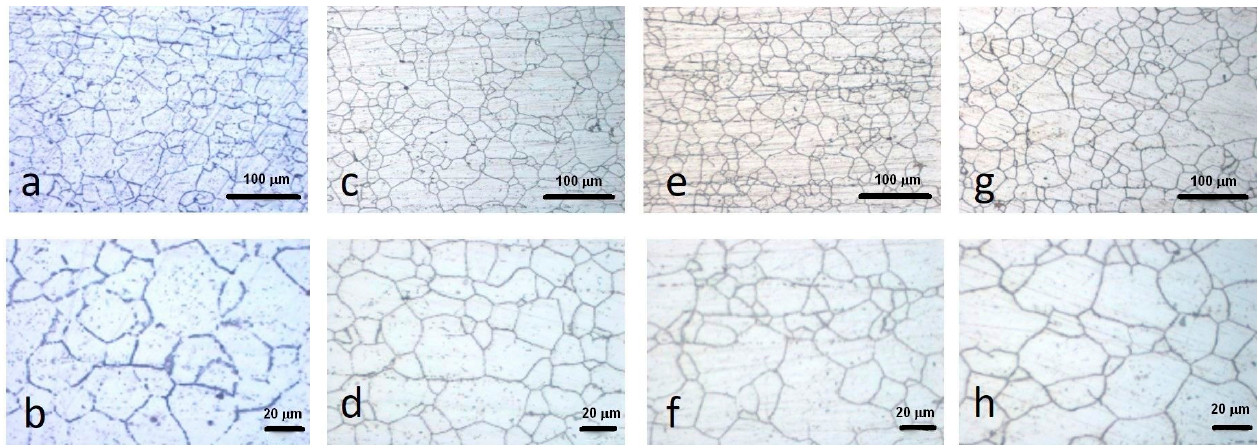
Figure 4. Optical micrographs showing the microstructure for unoxidized ( a , b ) and oxidized samples in supercritical static water for 720 h ( c , d ), 1440 h ( e , f ), and 2160 h ( g , h ) at 550 °C at (×200) and (×500) magnifications. The micrographs obtained at (×200) and (×500) magnifications for unoxidized sam ‐